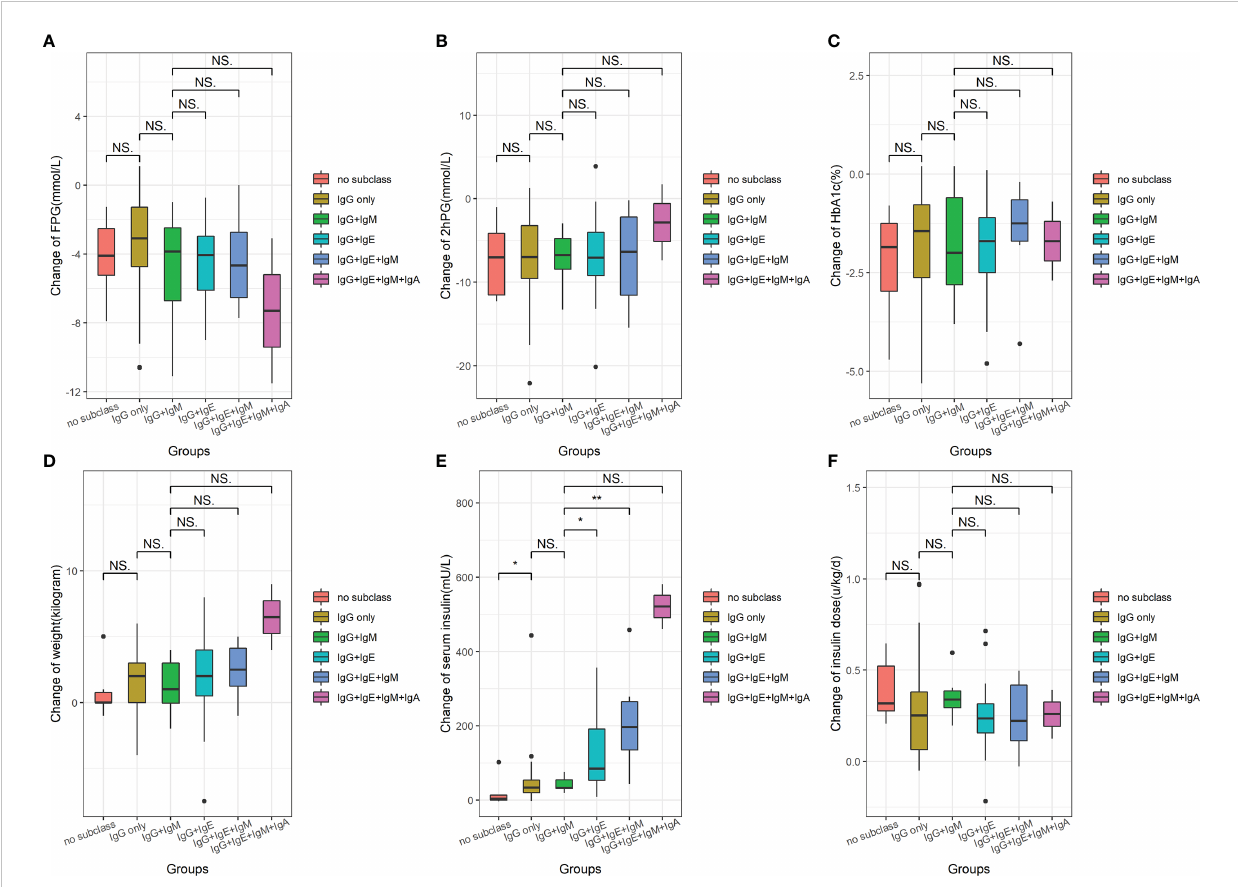
FIGURE 4 The boxplot showing the median change of FPG (A) , 2hPG (B) , HbA1c (C) , weight (D) , serum total insulin (E) , and daily insulin dose (F) from baseline among different IA subclasses groups. NS, no signi fi cance; * P<0.05; ** P<0.005. FPG, fasting plasma glucose; 2hPG, 2-hour postprandial blood glucose; HbA1c, glycated hemoglobin. Data of serum fasting insulin measured prior to and post-insulin administration were available in 94 IA-positive patients.